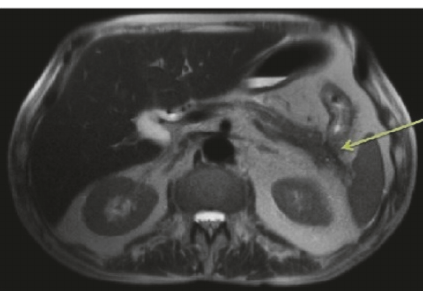
Figure 2: CTA showing a pancreatic tail lesion, with a focus of fluid and interval diffuse progression of colonic wall thickening. The pancreatic tail was inseparable from the colon, with a possible connection between the colon and the pancreas. Green arrow denotes possible connection between the colon and pancreas.